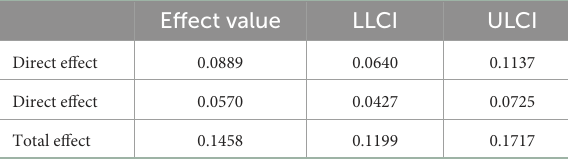
TABLE 3 The analysis results of mediating effect of